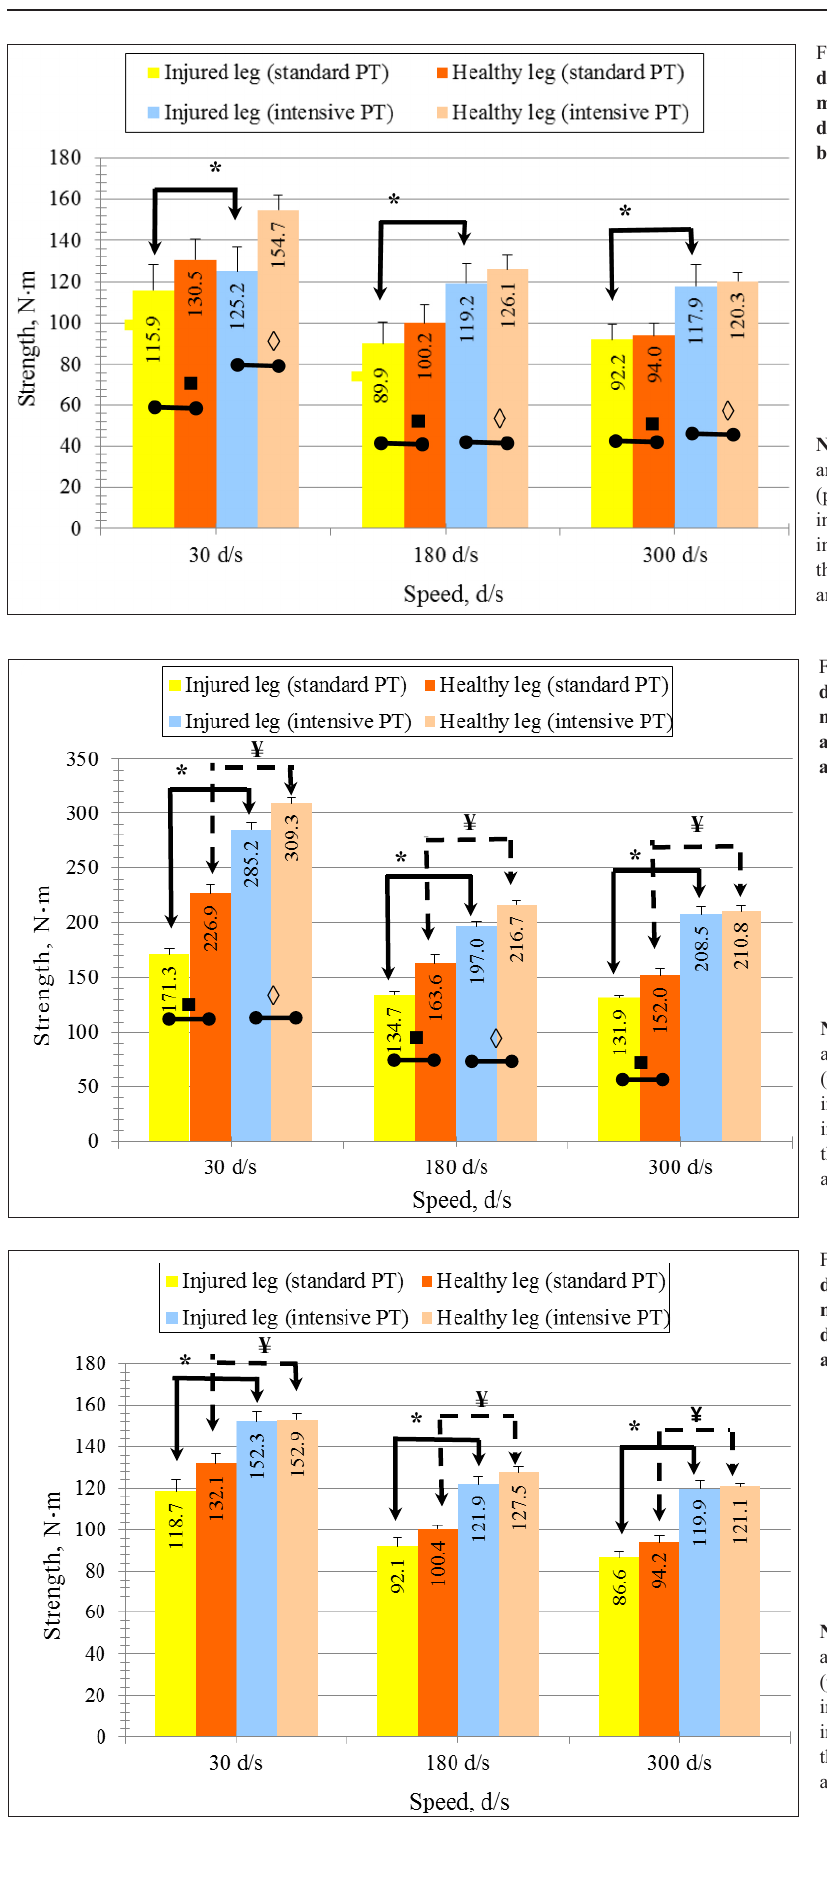
Figure 4. Healthy and injured leg, different physical therapy techniques, maximum muscular flexion strength at different speed of muscle contraction, after